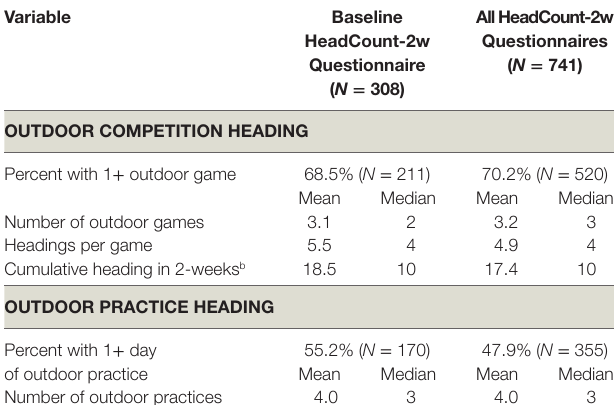
Table 1 | Summary of heading and unintentional head impacts reported by 308 a amateur soccer players who reported soccer activity in the baseline